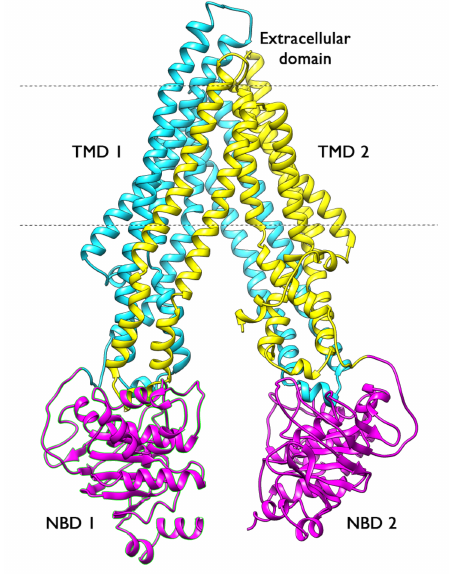
Figure 1. Crystal structure of mP-gp (PDB ID: 4M1M) in the inward-facing conformation. The NBDs are shown in magenta and the TMDs are shown in cyan and